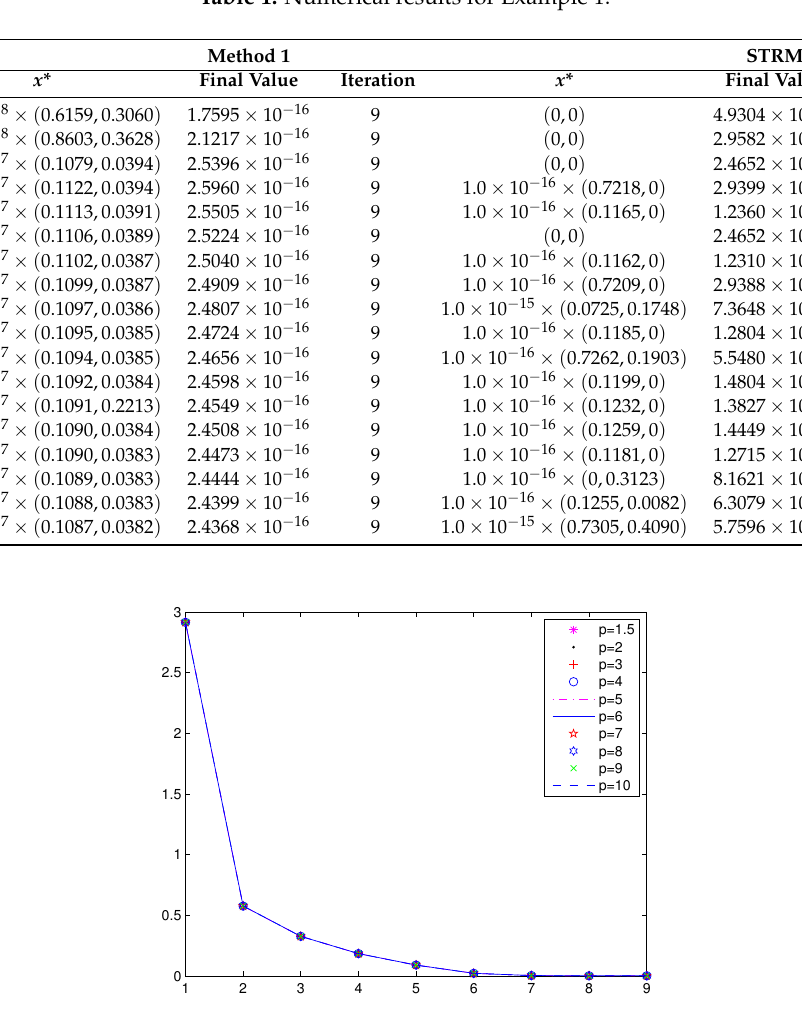
Figure 1. Numerical results for Example 1 by Method 1. The x -axis represents the iteration step; the (cid:107) F ( x , y ) (cid:107) 2 . y -axis represents θ ( x , y ) = 1 2